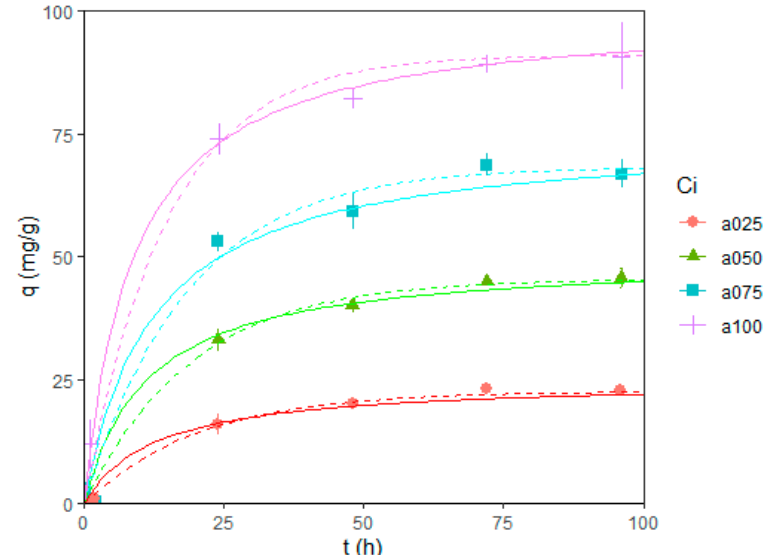
Figure 2. Adsorption curves of blue indigo dye for different initial concentrations C i (25, 50, 75, and 100 mg/L). Points with error bars represent measurements with experimental errors. Dashed lines represent a fit to the first-order model in Equation (7). Solid lines represent a fit to the second-order rate